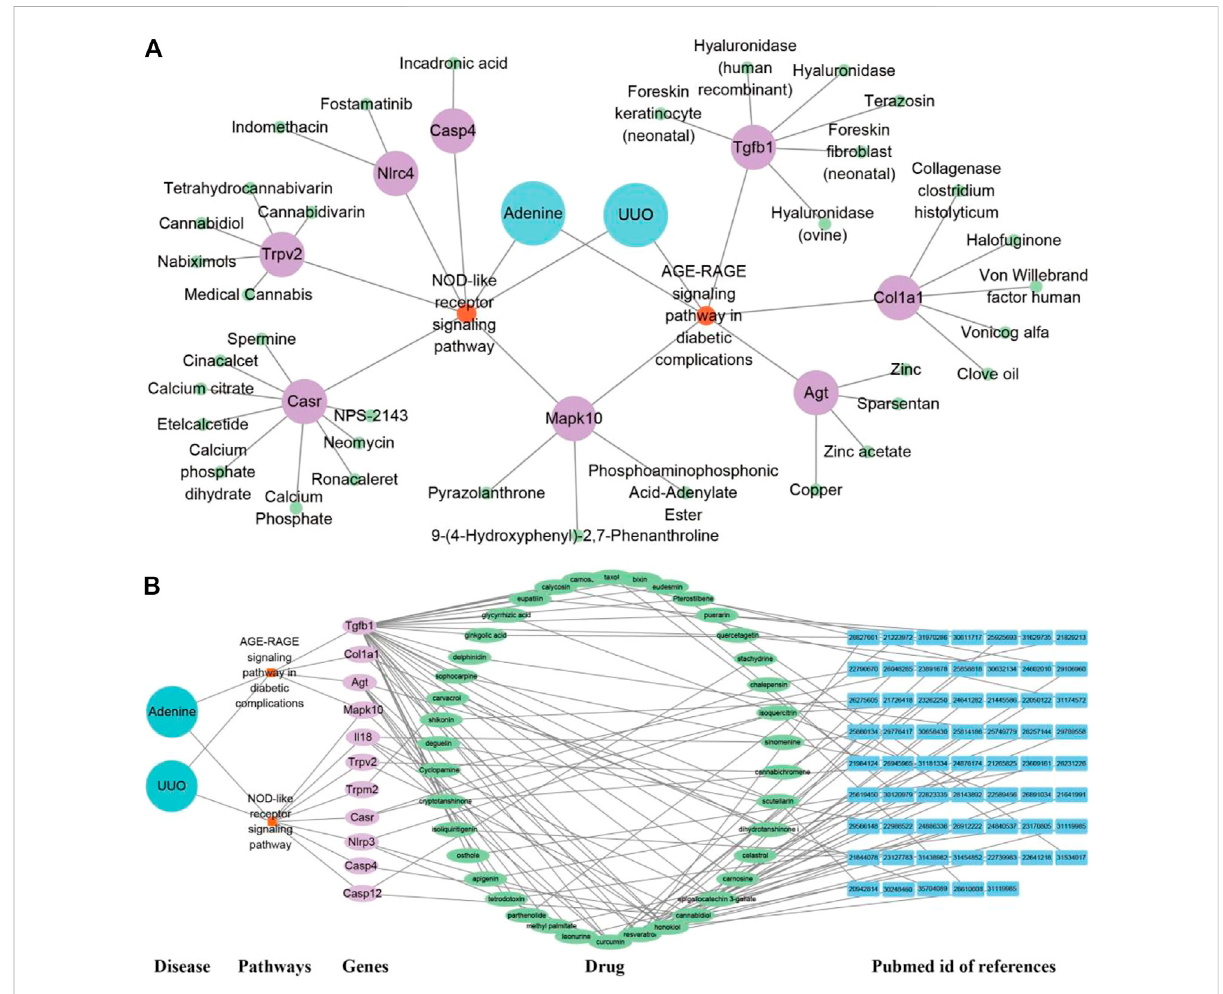
FIGURE 9 Potential drug prediction of renal fi brosis (RF) using network pharmacology analysis. (A) “ Disease-pathway-gene-drug ” interaction network of adenine and UUO models in the Drugbank database. The diseases were labeled by lake blue, pathways by orange, genes by purple, and drugs by green. (B) “ Disease-pathway-gene-drug-reference ” network of adenine and UUO models in the HERB database. The diseases were labeled by lake blue, pathways by orange, genes by purple, drugs by green, and PubMed id of references by